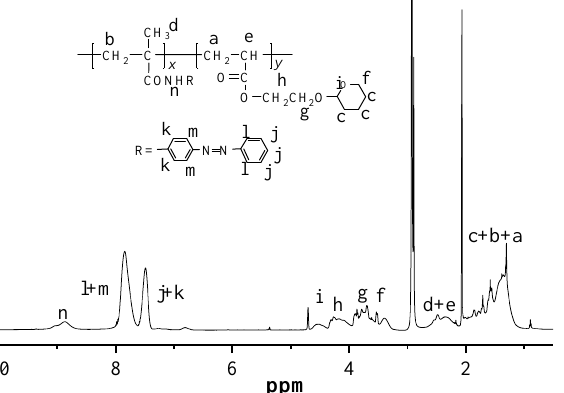
Figure 2. 1 H-NMR spectrum of PMAAAB- ran -P(THP-HEA) ( F MAAAB = 0.5351).